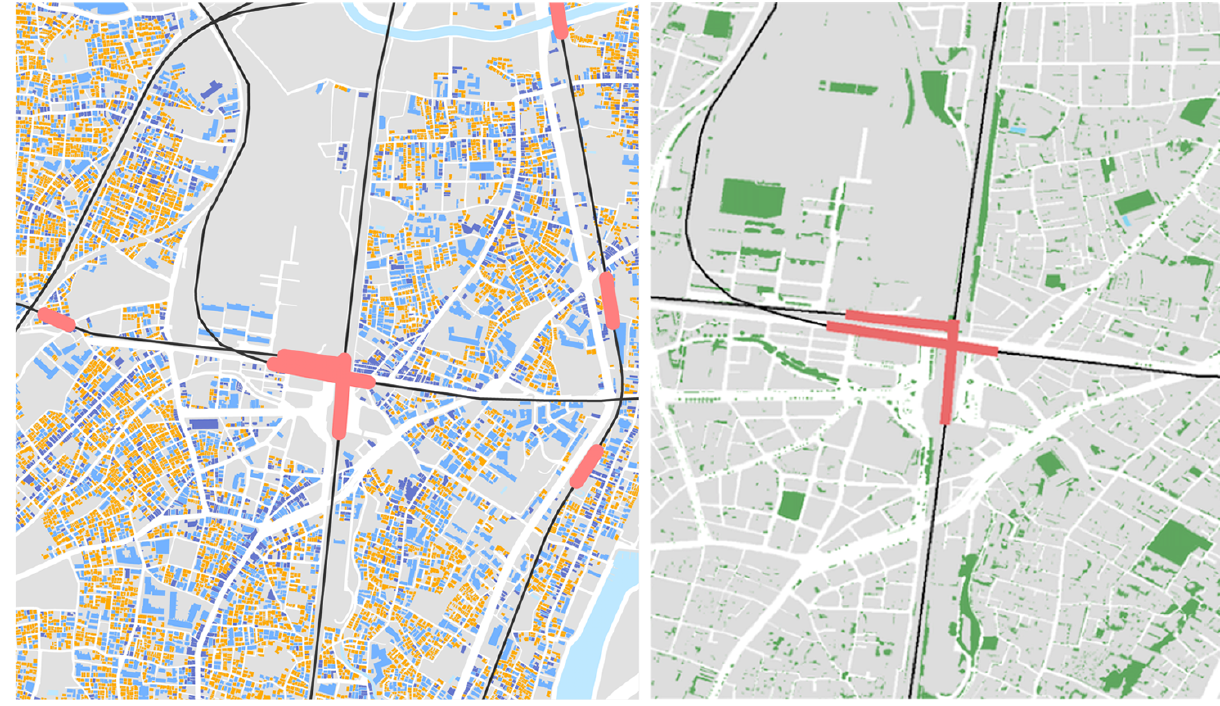
Figure 6. Contrast in scale and green spaces between the roji area and modern urbanity. Source: Courtesy of KEIO University and Tokyo